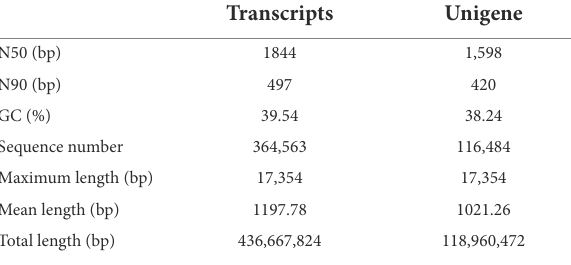
TABLE 1 Summary data of the assembled transcripts and unigenes in B. luminifera